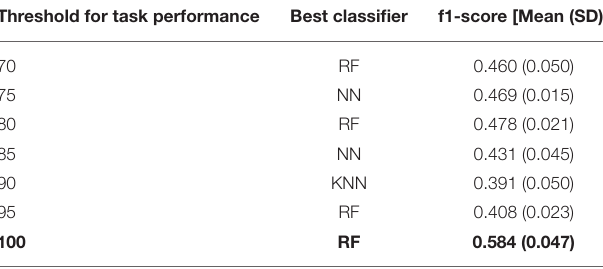
TABLE 9 | Best score achieved by the model to predict task modality at each threshold of task